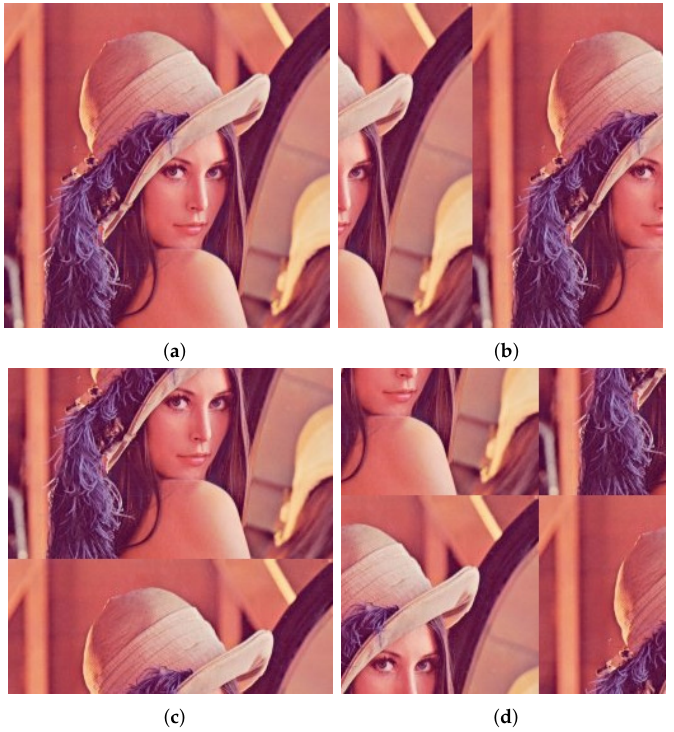
Figure 3. Examples of a cyclic permutation over the Lena image. ( a ) RGB image of Lena. ( b ) Left horizontal cyclic permutation CP { k x = − 150, k y = 0 } result. ( c ) Vertical upward cyclic permutation CP { k x = 0, k y = 150 } result. ( d ) Left cyclic permutation CP { k x = − 100, k y = 0 } followed by a upward cyclic permutation CP { k x = 0, k y = − 100 }